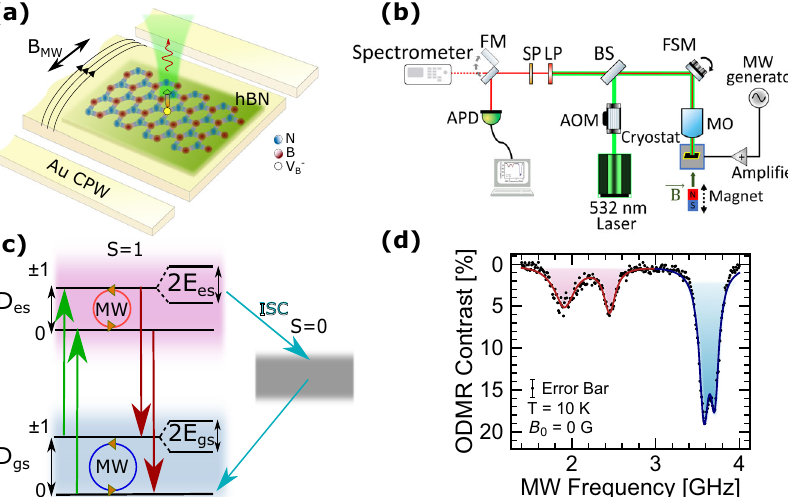
defects in hBN. hBN fl akes are transferred onto a gold- Fig. 1 Spin-active V (cid:1) defects in hBN. a Schematic of the device used to probe spin transitions of V (cid:1) B B fi lm coplanar waveguide (CPW) and the generated microwave fi eld B MW induces rotations of the defect spin state which is read out via PL. b Schematic of the experimental setup. AOM acousto-optic modulator, BS beam splitter, FSM fast-steering mirror, MO microscope objective, LP long-pass fi lter, SP short- pass fi lter, FM fl ip mirror, APD avalanche photodiode. c Energy level diagram of the defect orbital states and their spin sublevels, which are split by D es and D j i spin sublevels of the ES. d Zero- fi eld ODMR spectrum at gs in the ES and GS, respectively. A non-radiative ISC to a singlet state is preferred from the ± 1 T = 10 K, excited with laser power P ≈ 3 mW and microwave power P ≈ 160 mW, showing distinct resonance dips from spin transitions in the ES (red) L MW and GS (blue) at their respective splitting frequencies. The error bar represents shot noise from photon